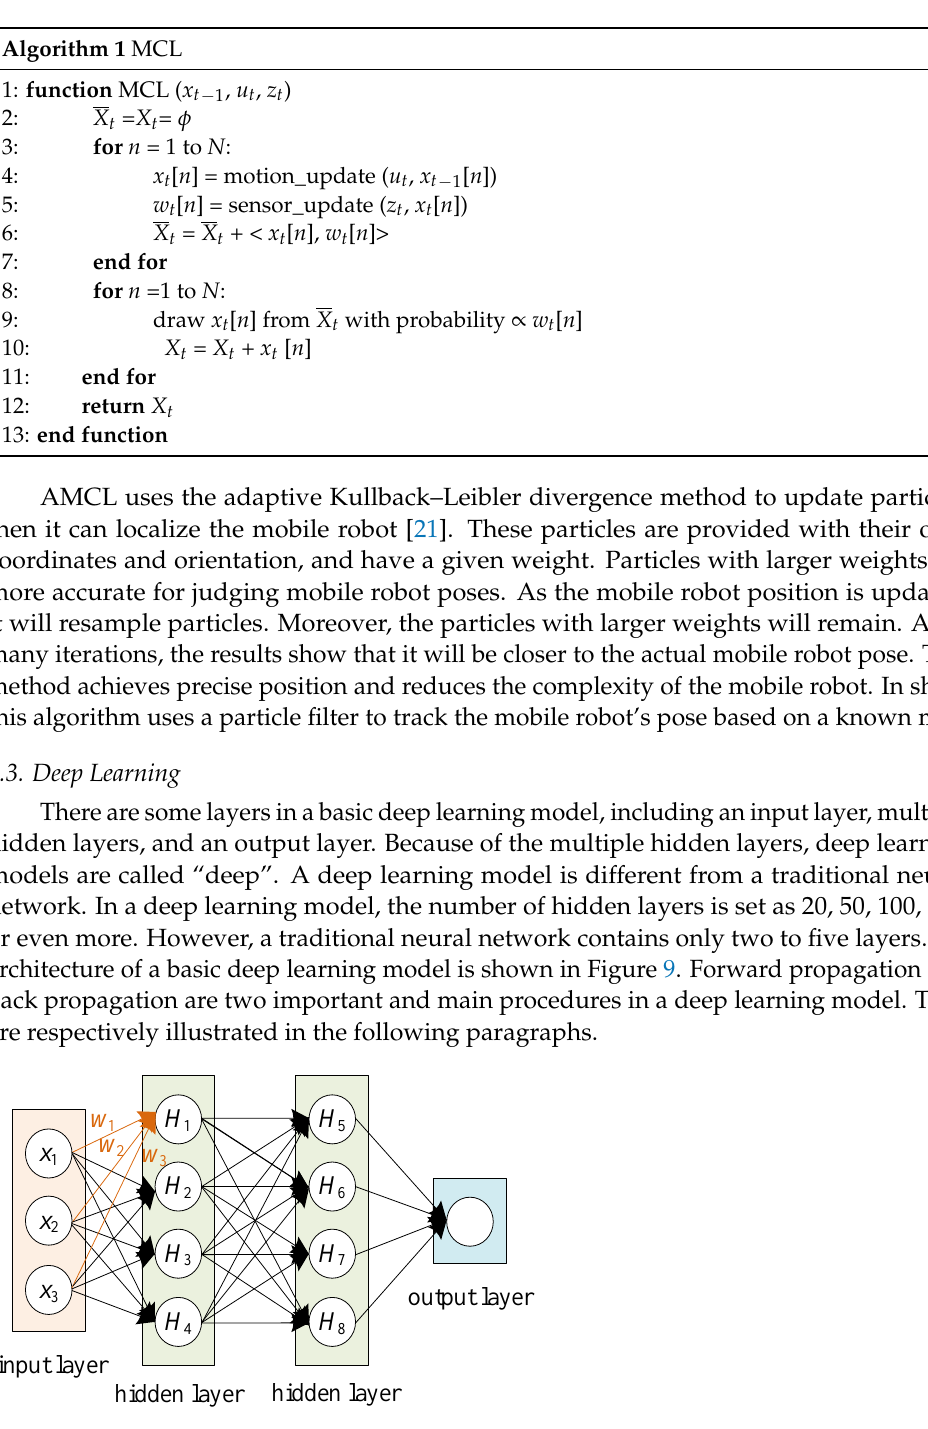
Figure 9. An architecture of a basic deep learning model.